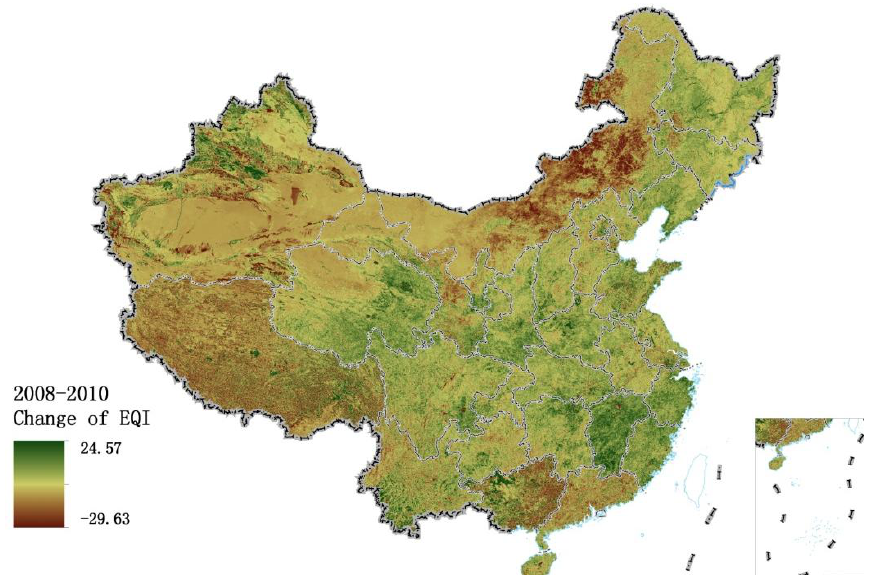
Figure 18. Change in EQI from 2008 to